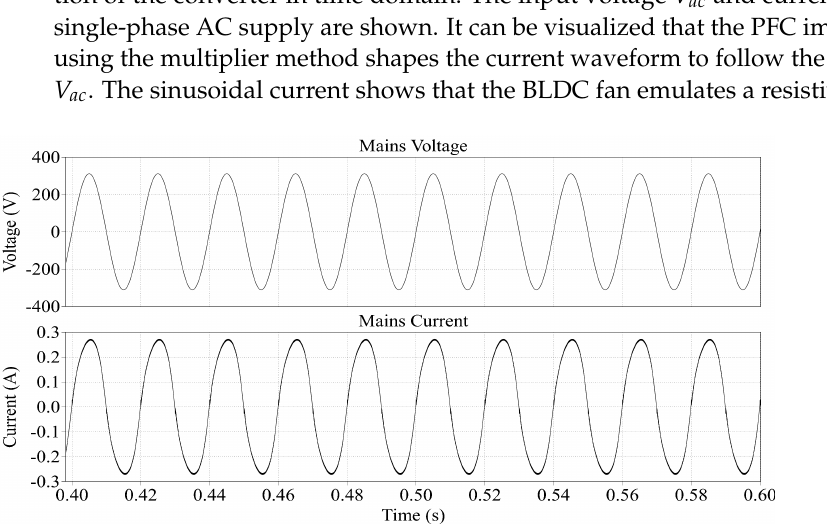
Figure 6. Steady state time domain simulation of the converter depicting the input voltage V ac and current i ac